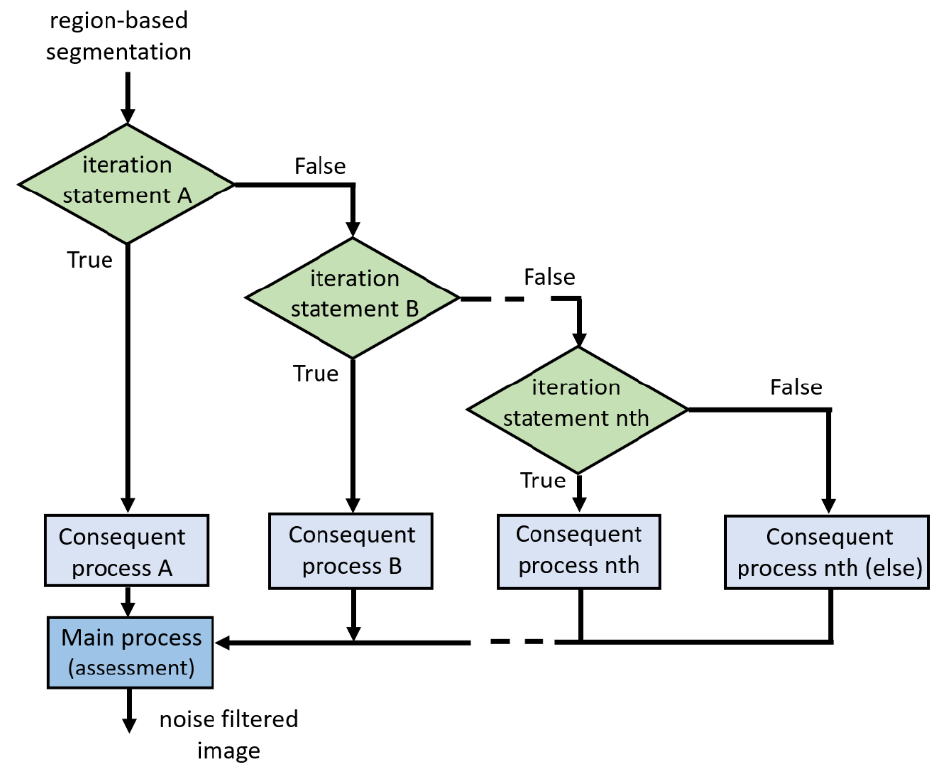
Figure 9. Iteration for noise reduction.